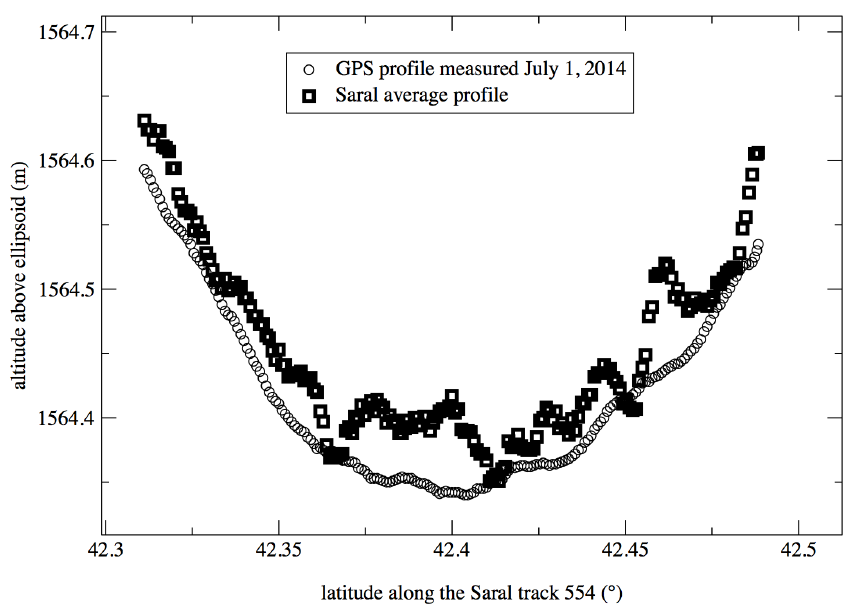
Figure 8. Vertical profiles along the track 554. The altimetry profile is an average over 15 first cycles at reference point corresponding to the GPS points of measurements. Ice1 retracker is